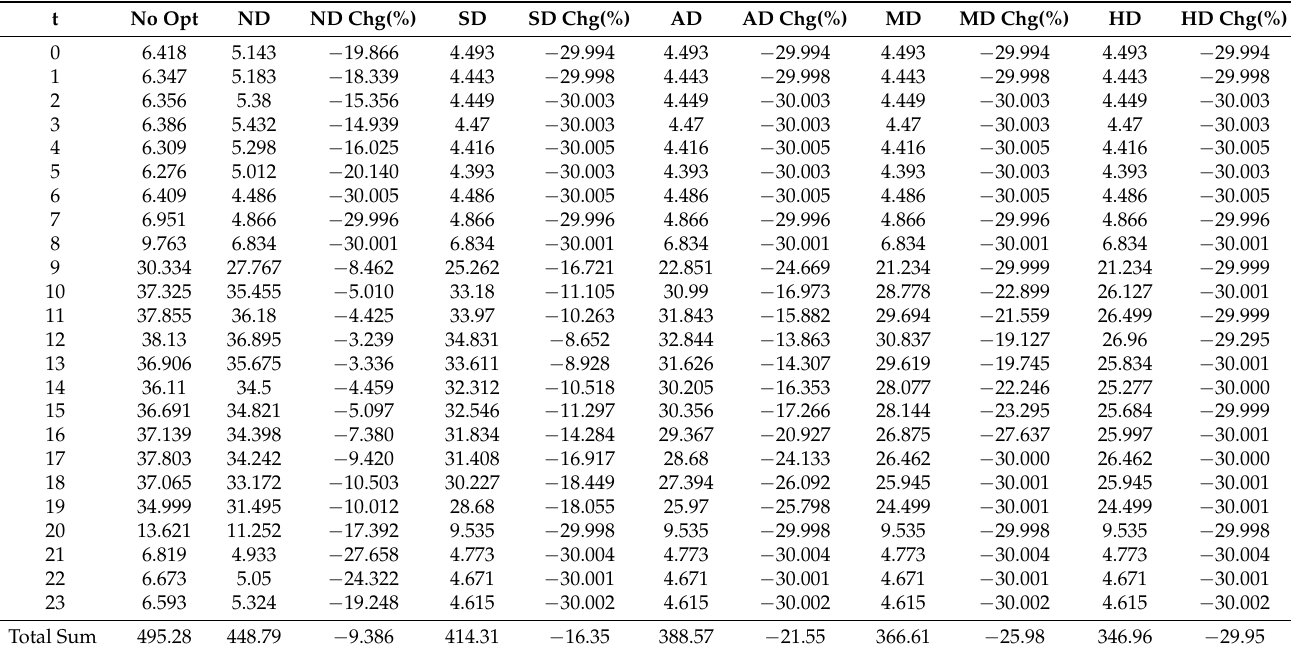
Table A1. Cost minimization and discomfort options for consumers.